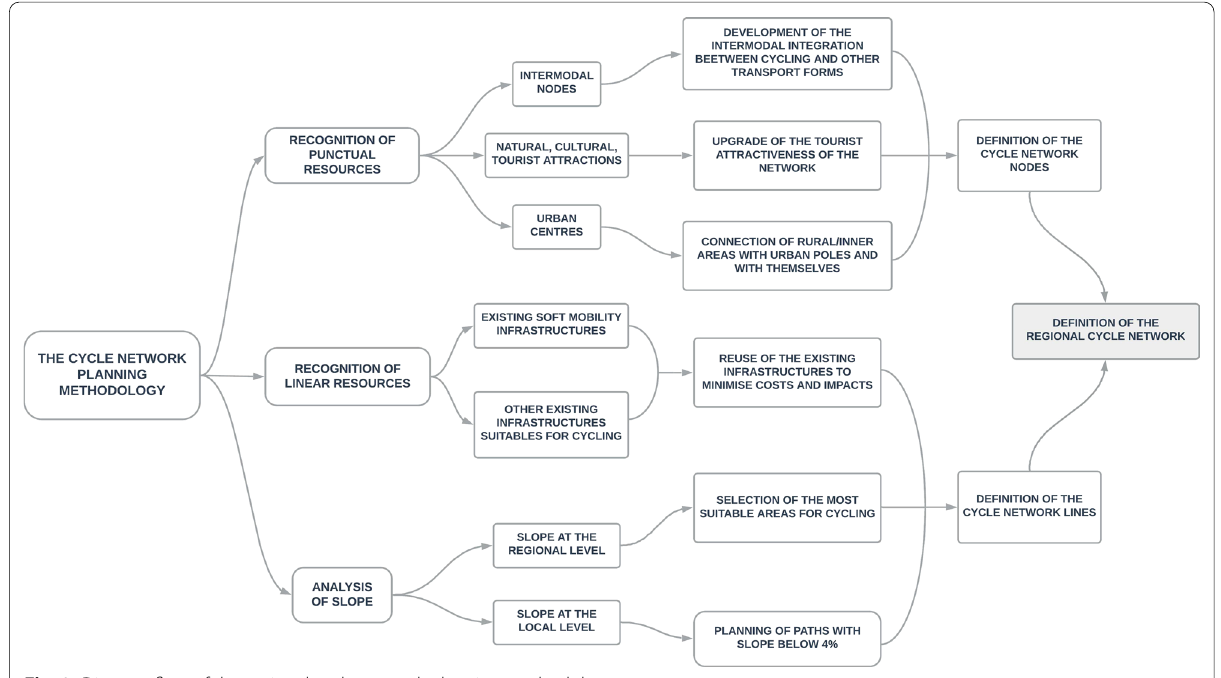
Fig. 2 Diagram flow of the regional cycle network planning